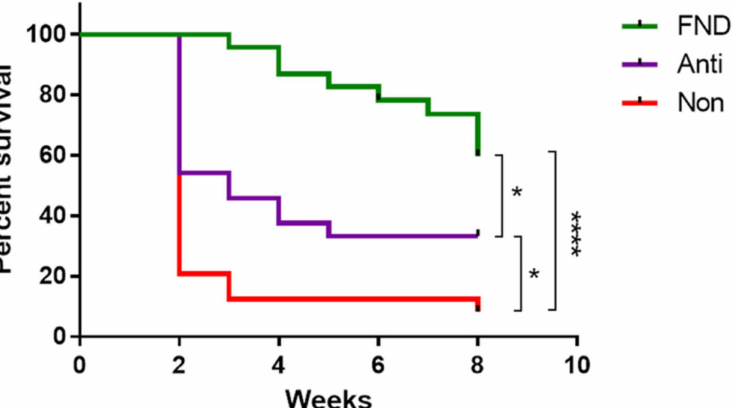
Figure 8. Preoperative fine needle diathermy of pathologic corneal blood and lymphatic vessels in vascularized high-risk eyes promotes graft survival after subsequent allogenic high-risk corneal transplantation. Two weeks after corneal suture placement to induce inflammatory corneal neovascu- larization, mice were treated with fine needle diathermy and anti-inflammatory drops (FND; green line) or with anti-inflammatory eye drops only (ANTI; purple line). Graft survival was compared to a control group which did not receive FND or anti-inflammatory therapy (NON; red line). Graft sur- vival was significantly prolonged when transplants were placed into recipient beds of pretreated groups (FND versus NON: 60.9% vs. 8.3%, p < 0.0001; ANTI versus NON: 33.3% vs. 8.3%, p = 0.0164). Between the two treated groups, our results showed that FND treatment significantly improved the graft survival in comparison to isolated anti-inflammatory therapy (FND versus ANTI: 60.9% vs. 33.3%, p < 0.05). (* p < 0.05; **** p < 0.0001). From Le et al. 2018